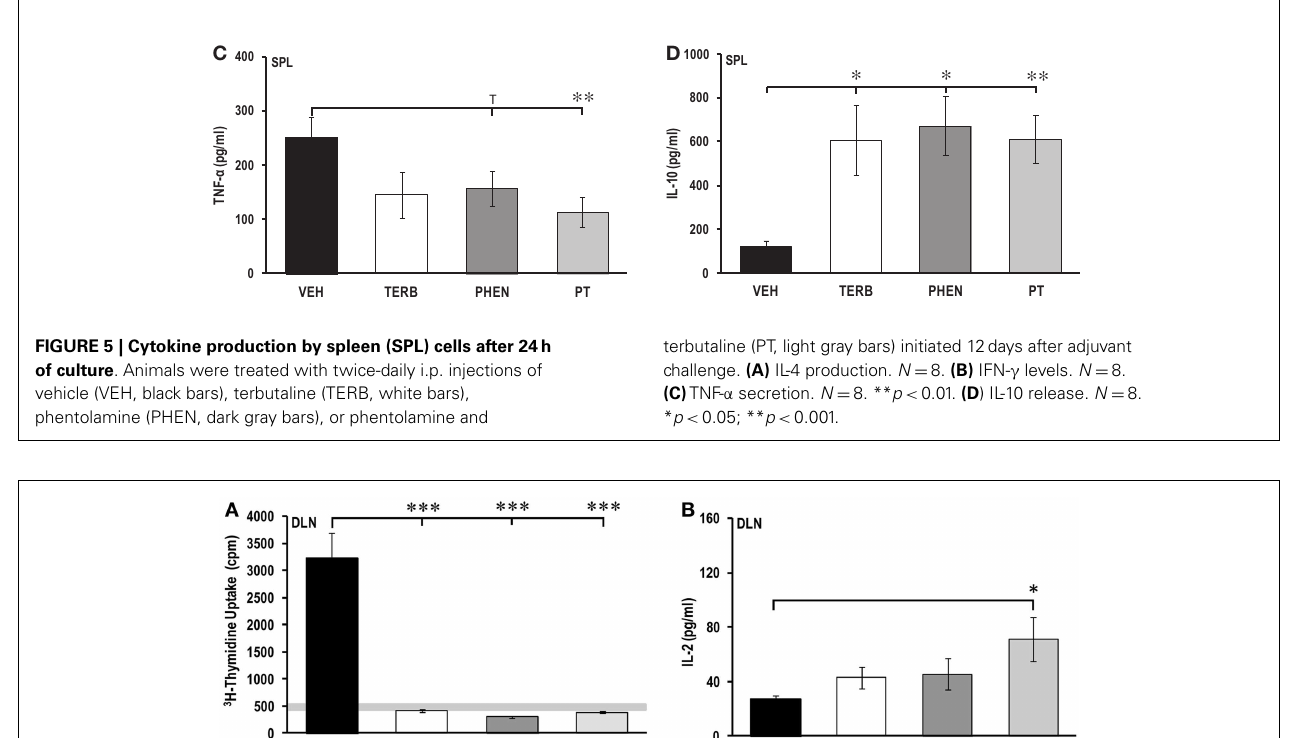
12days after adjuvant challenge. (A) All drug treatments suppressed proliferation of DLN cells compared withVEH treatment. Horizontal light gray bar demonstrates non-specific background. (B) IL-2 production by DLN cells is elevated in PT compared withVEH treatment. N = 8. * p < 0.5; ** p <